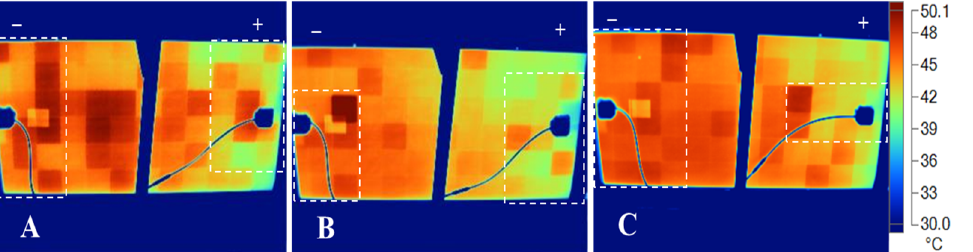
Figure 7. IR thermograms of the 3 old solar panels ( A – C ) affected by PID under clear sky outdoor conditions. Corresponding defects areas in Figure 6 are marked in white. The negative terminal ( left ) and the positive terminal ( right ) are indicated above the modules.